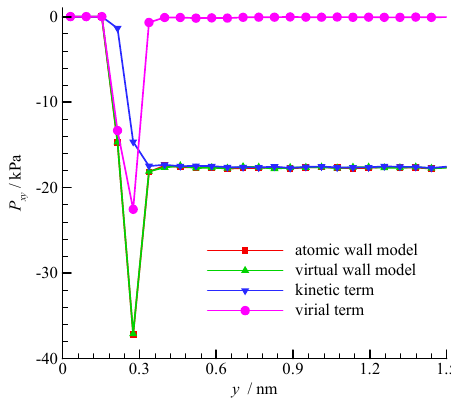
Figure 6. Shear stress profiles of the atomic and virtual wall MD simulations near the wall in Couette flow, using the dimensional wall distance.